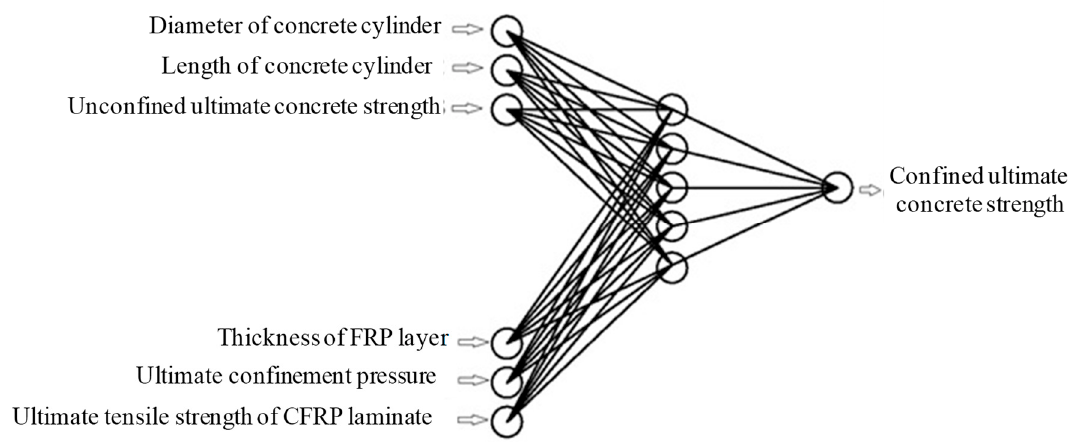
Figure 2. A three-layer artificial neural network.